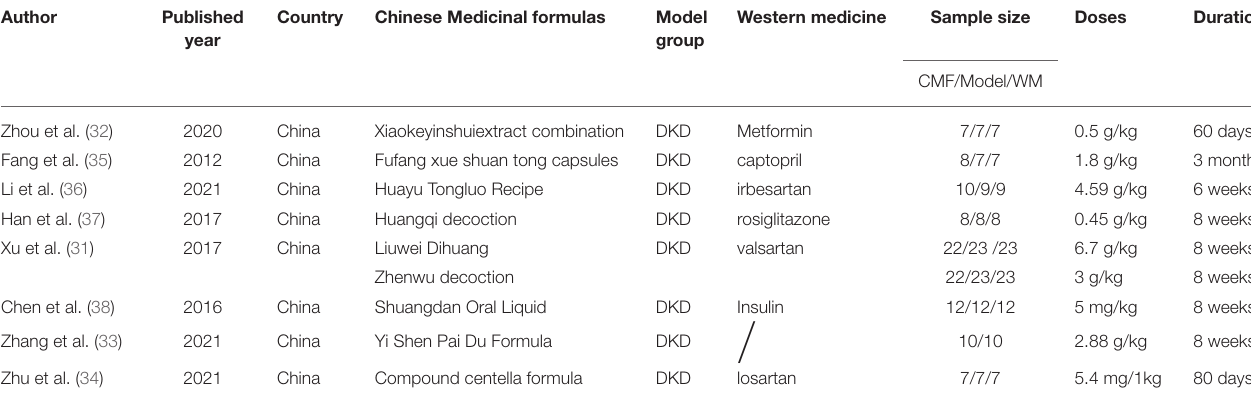
TABLE 1 | Characteristics of included